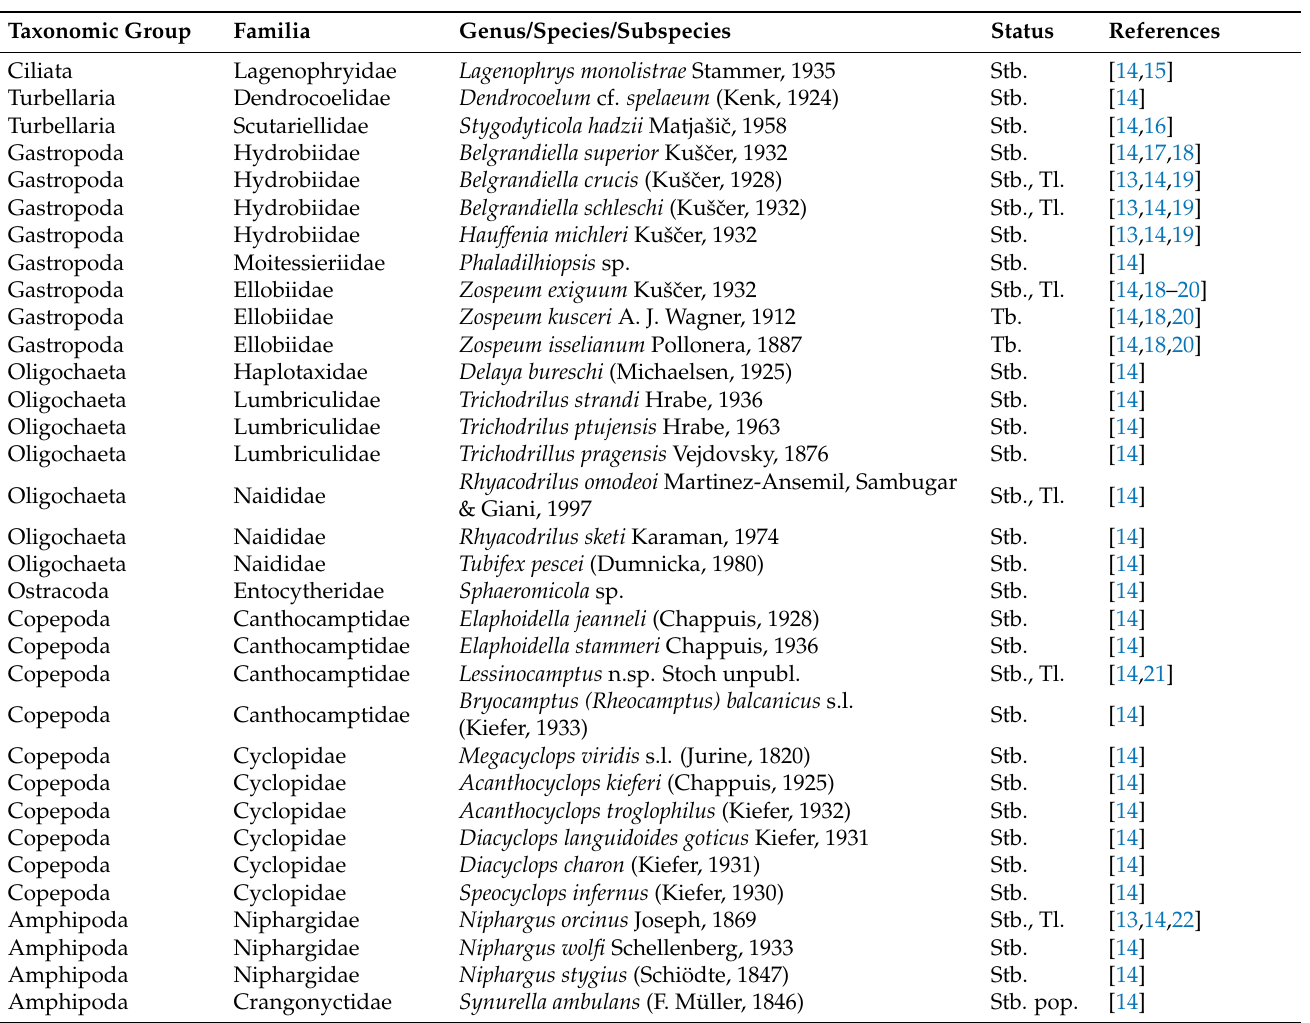
Table 1. An updated list of stygobiotic and troglobiotic species encountered in the Križna jama. Tb.—terrestrial (troglobiont), Stb.—aquatic (stygobiont), Stb. pop.—stygobiotic population, Tl.—type locality in Križna jama, new—new, unpub- lished